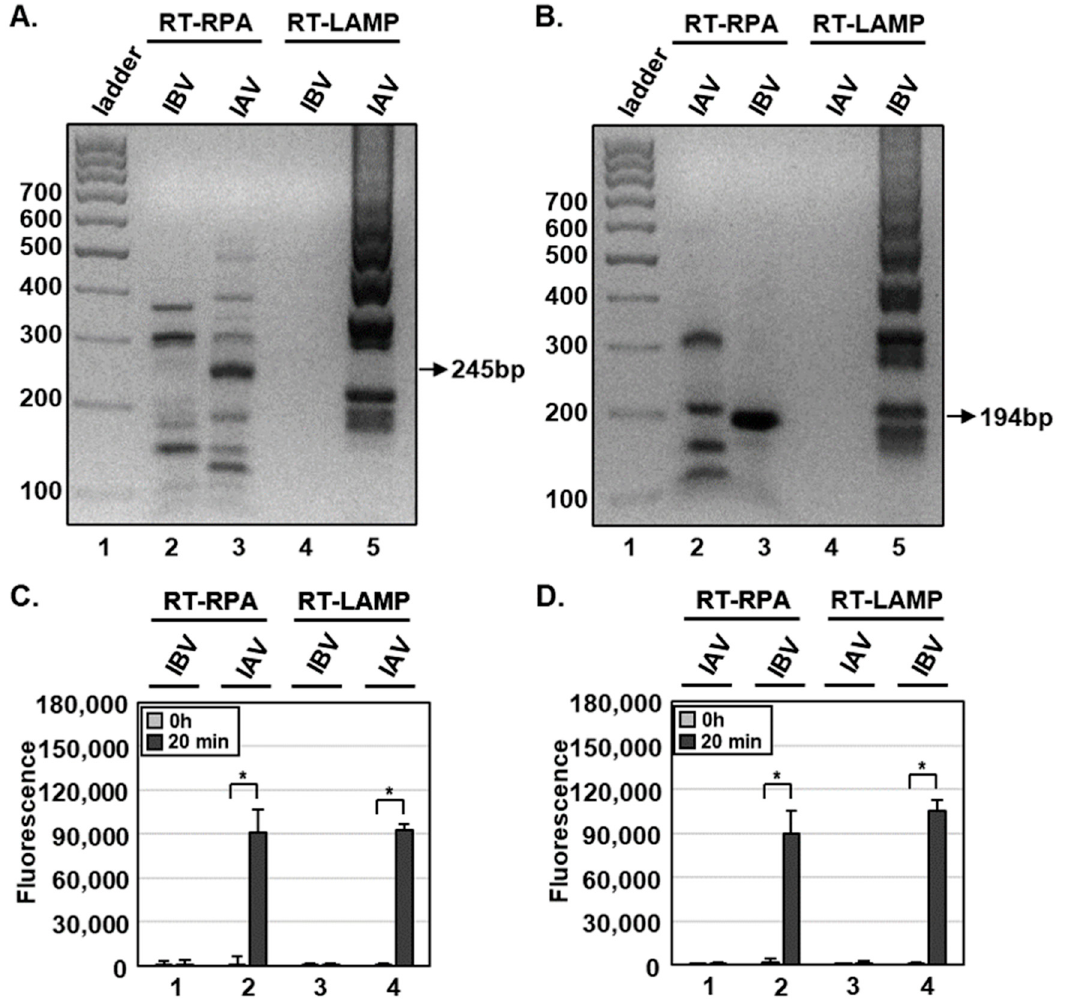
Figure 2. Detection of influenza viruses using DETECTR combined with fluorescence assay. ( A , B ) One hundred plaque forming units (PFUs) of IAV and IBV per reaction were used to amplify viral nucleic acids by either RT-RPA or RT-LAMP with primer sets specific for the IAV M ( A ) or IBV HA ( B ) gene. RT-RPA or RT-LAMP amplicons for the IAV M or IBV HA gene were visualized by gel electrophoresis. Sizes of amplicons for IAV M and IBV HA genes were approximately 245 and 194 bp, respectively. ( C , D ) RT-RPA and RT-LAMP amplicons were detected by DETECTR combined with fluorescence assays using gRNAs targeting the IAV M ( C ) or IBV HA ( D ) gene. Fluorescence signals of DETECTR on RT-RPA or RT-LAMP amplicons were saturated within 20 min. Values are presented as means ± s.d (error bars) ( n = 3 replicates; * p < 0.05 between samples, two-sample t -test). Table 1. Primers for RPA and LAMP.